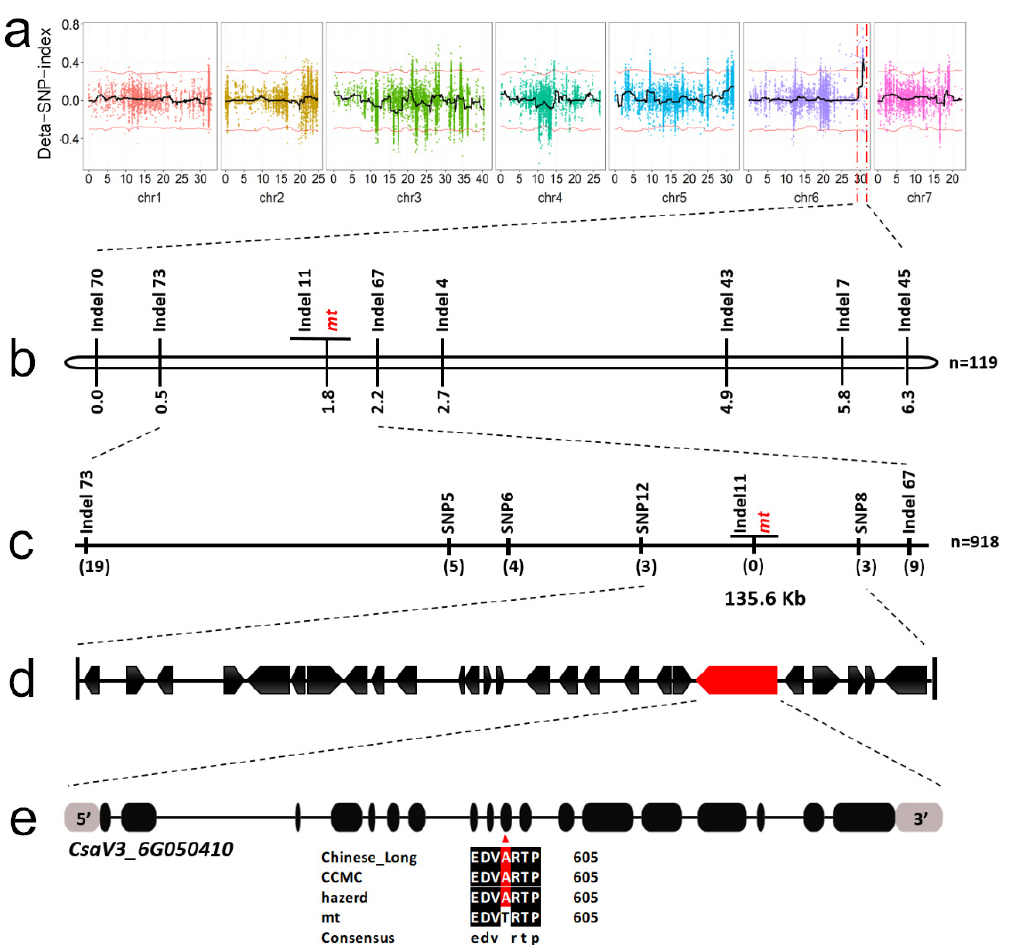
Figure 3. Linkage mapping of the mt locus. ( a ) BSA-seq mapped the mt locus to one end of chromosome 6. The black curve represents the ∆ (SNP-index), and the red curve represents the 95% threshold line. ( b ) A genetic map that delimits the mt locus to a 1.8 cM region. ( c ) High-resolution map for the mt locus in a 135.6 kb region. ( d ) Physical position of the mapping region. The black arrows indicate genes in the interval. ( e ) The annotated candidate gene CsaV3_6G050410 within the mt locus. Black rectangles and black lines represent the exon–intron structure, respectively. An SNP in the tenth exon (red arrow) of CsaV3_6G050410 resulted in an amino acid change from A in Chinese long, CCMC and hazerd to T in mt mutant.